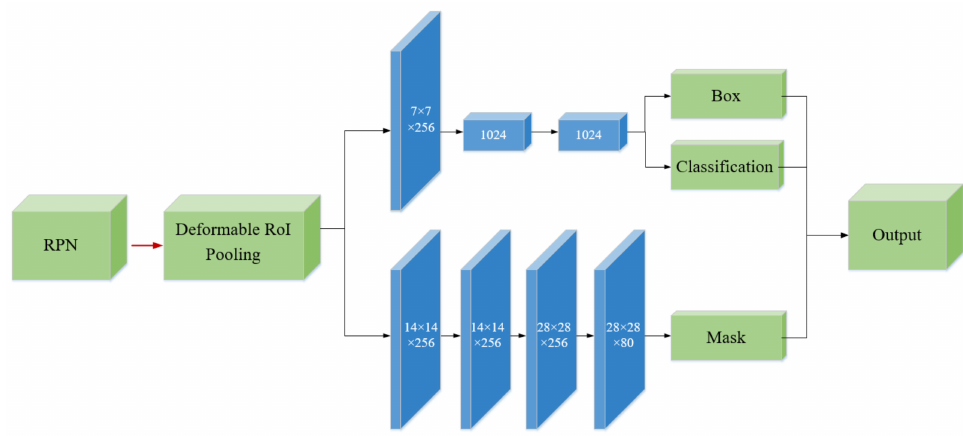
Figure 13. Schematic diagram of the FPN network